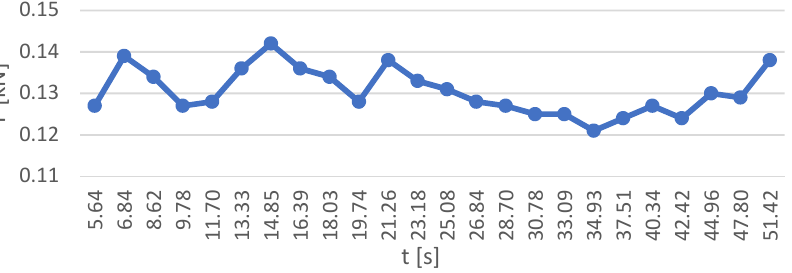
( b ) Figure 5. Evolution of forces versus time—10 kg load for cycle of an initial repetition ( a ) and of a final repetition ( b ). For a final repetition (R24), the evolution of the force for a cycle of one repetition is presented in Figure 5b. In this case, interesting mechanisms were observed. First, the du ‐ ration of R24 was 4.38 s, with t a being 0.41. A short t d of 0.24 s was followed by a holding time (t h ) of 3.34 s. A sudden decrease of 0.39 s ended the final repetition cycle. This result, observed and measured at R24 whereby the subjects maintained muscle contraction for a longer period, was surprising because there is energy consumption and the natural tendency would have been exactly the opposite. The explanation lies in the psychological pressure related to the failure to add a new repetition to the MNR set. How ‐ ever, there was an interesting implication of maintaining the muscle contraction in the proximal area of the maximum force (i.e., 85–90%) related to the execution of the exercise through which the MNR strategy determines this surprising behavior. The amplitude of the oscillations on this level was higher, which confirms the effect of the subject ʹ s fatigue, close to the exhaustion of the set.